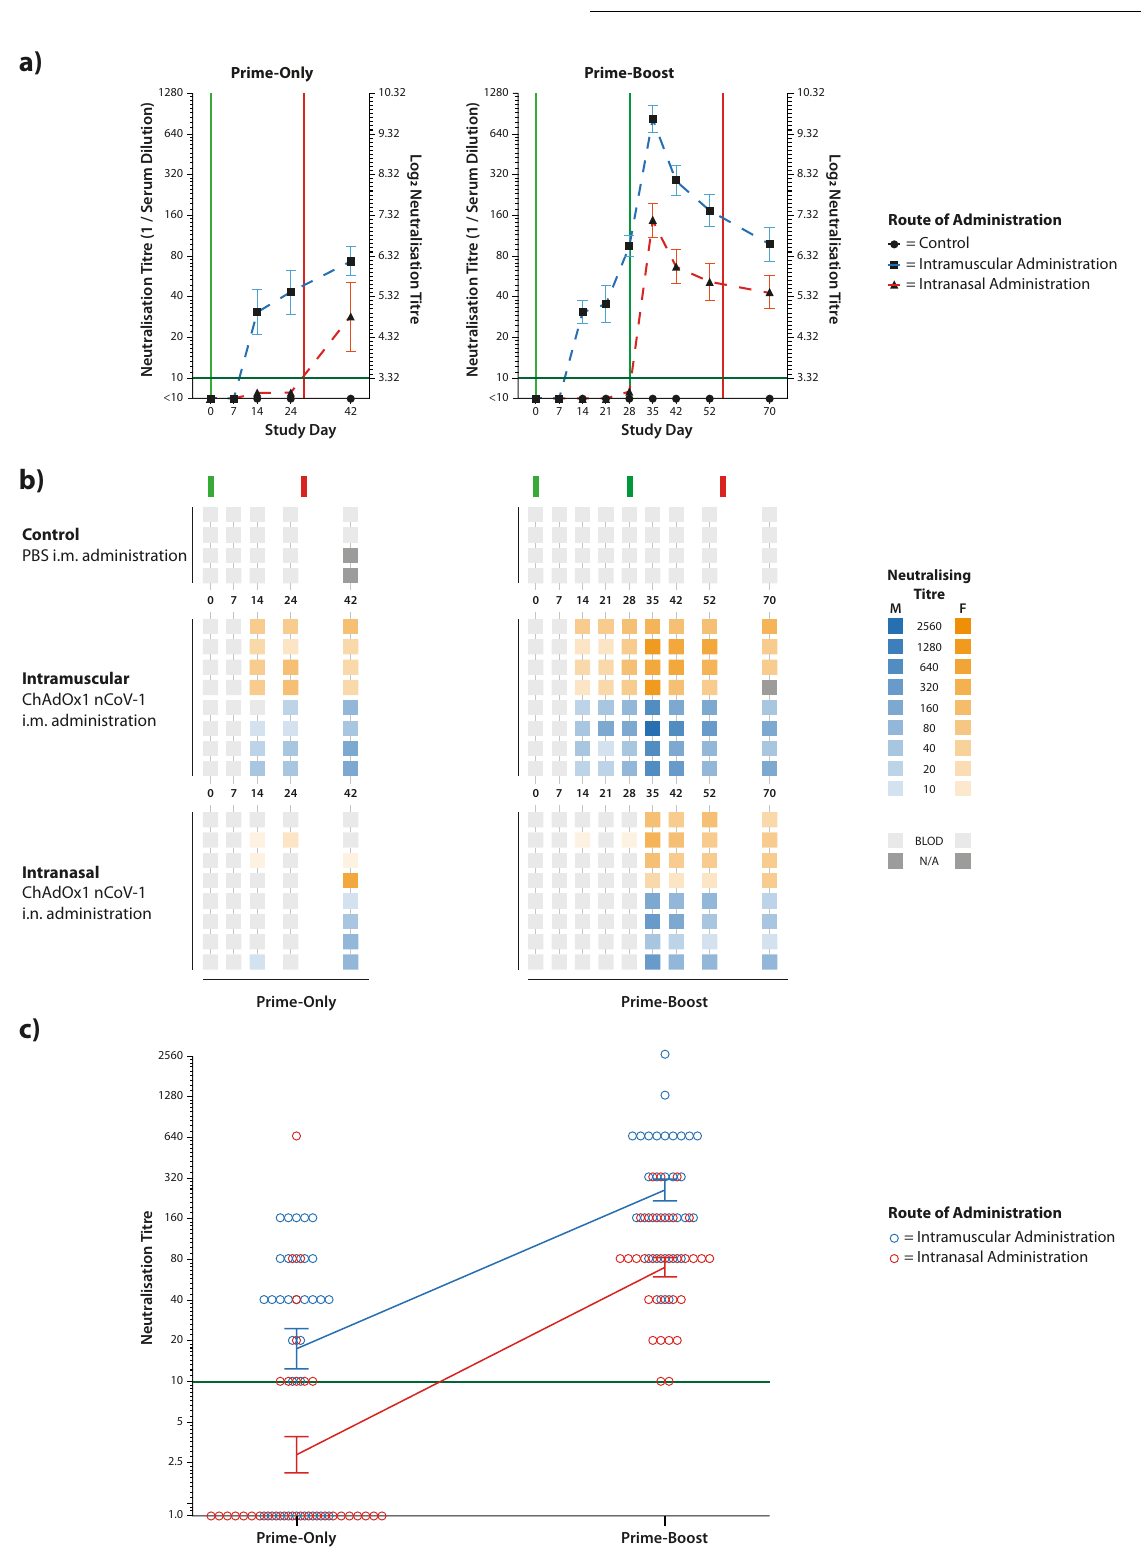
Virus shedding following challenge Nasal wash, rectal and oral swab samples were collected at the prescribed time points of the study (Fig. 1). None of the samples collected pre-challenge (study day 24 for prime-only animals;